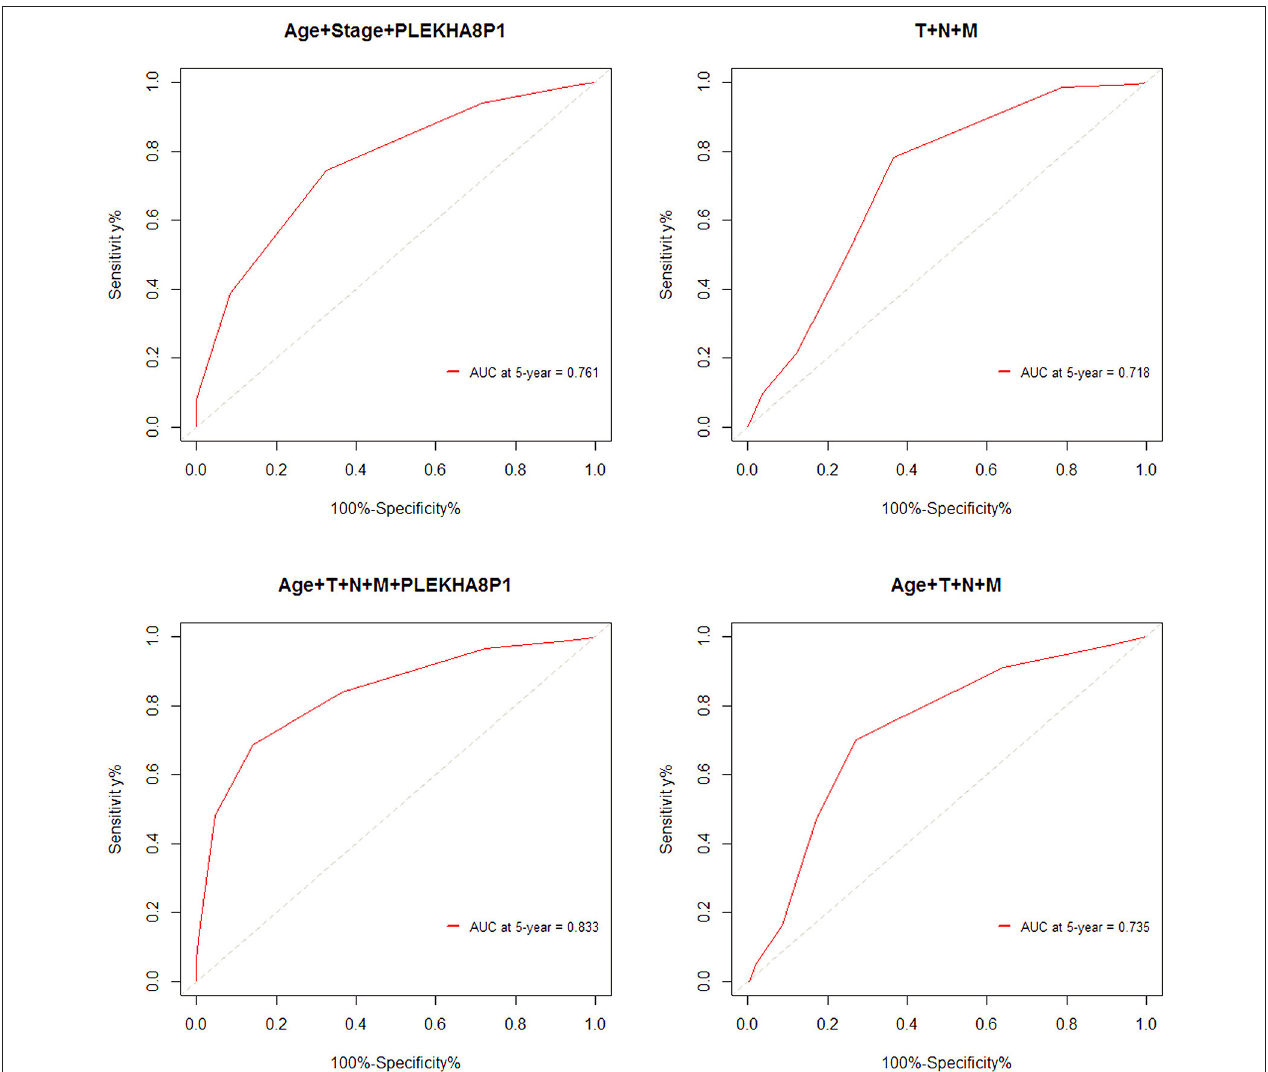
FIGURE 4 | ROC curve for evaluating the 5-years survival rate of colon cancer patients based on combined